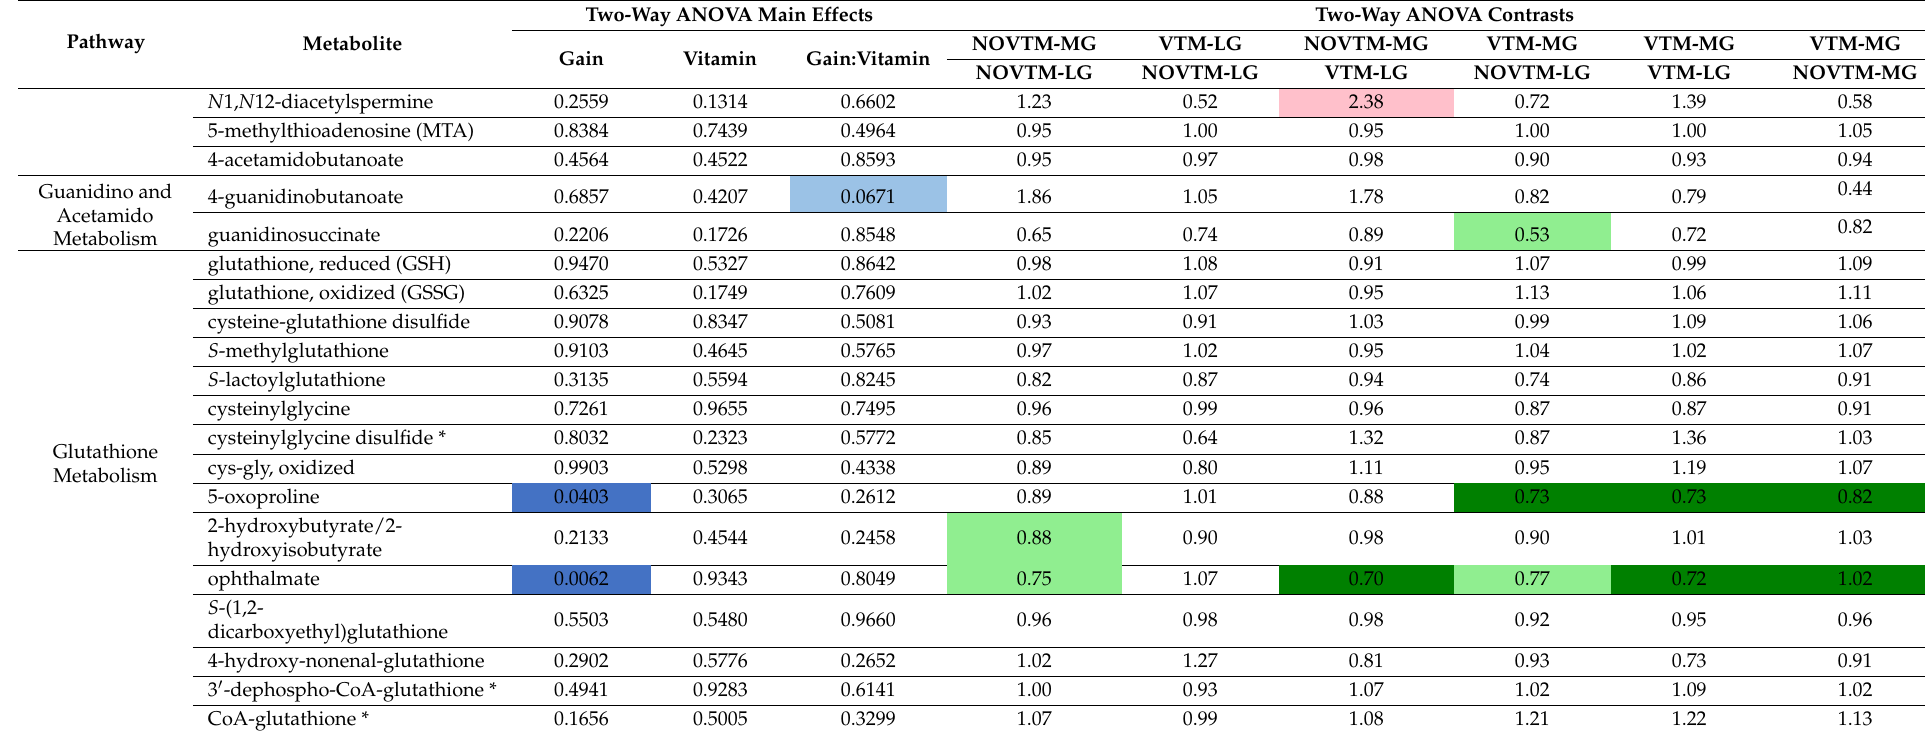
Red and green shaded cells indicate p ≤ 0.05 (red indicates that the mean values are significantly higher for that comparison; green values significantly lower). Light red and light green shaded cells indicate 0.05 < p < 0.10 (light red indicates that the mean values trend higher for that comparison; light green values trend lower). For the ANOVA, blue-shaded cells indicate p ≤ 0.05; light blue-shaded cells indicate 0.05 < p < 0.10. Metabolites denoted with * indicates a compound that has not been confirmed based on a standard but are confident in its